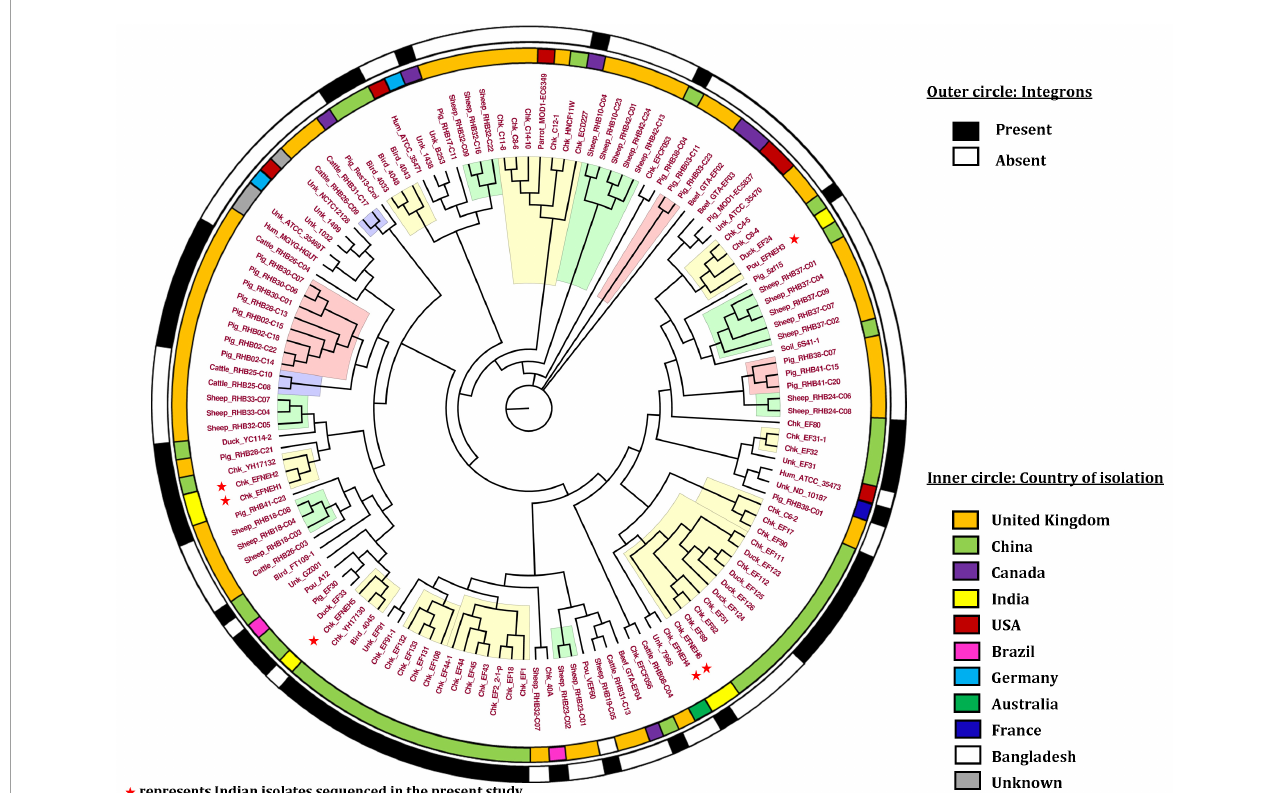
FIGURE7 Phylogenetic analysis of E. fergusonii genomes included in the